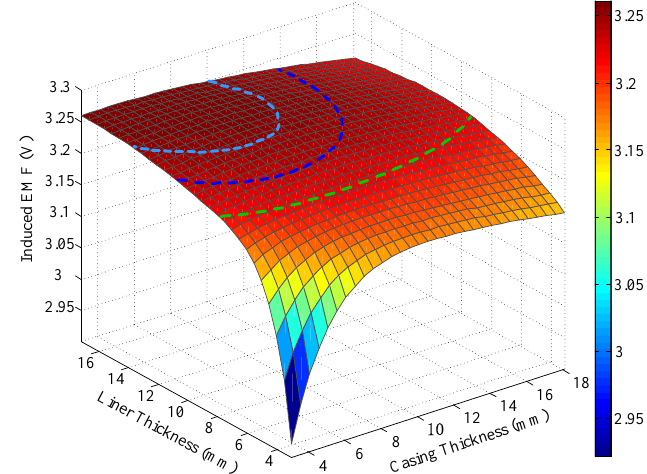
Figure 2. Induced electromotive force (EMF) in receiving coils at 20 ms.